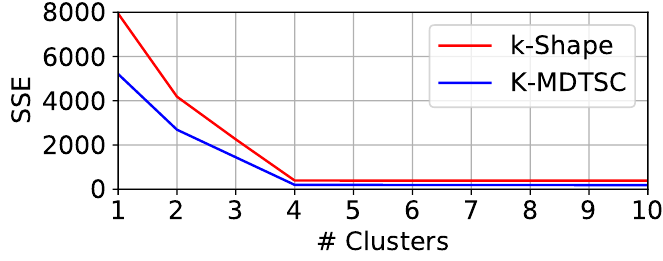
Figure 2. SSE Score of the synthetic data.